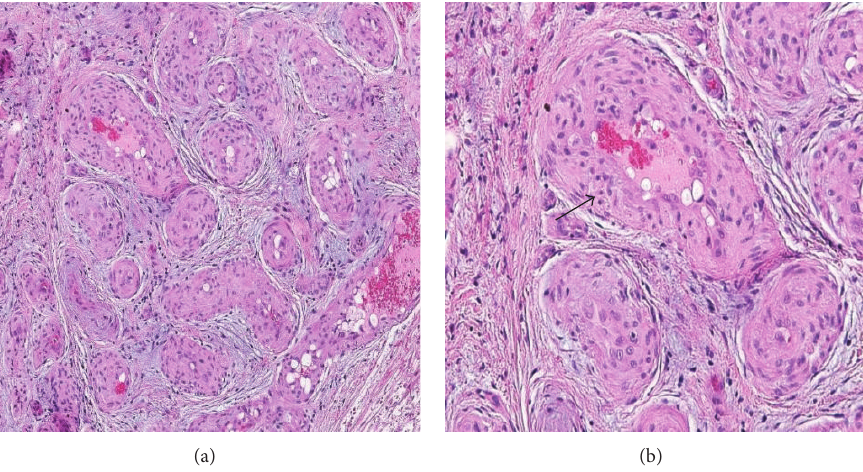
Figure 1: Representative histological images of the first biopsy: (a) HE: low magnification, showing numerous blood vessels. (b) HE: higher magnification, showing thick vessel walls with proliferated endothelium (arrow) and some inflammatory infiltrate.